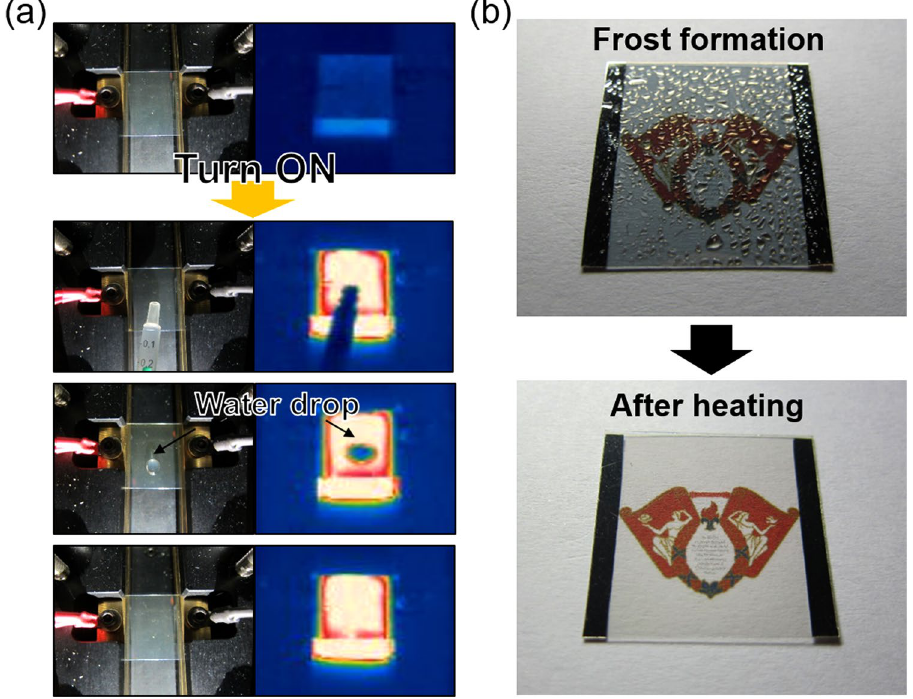
Figure 13. ( a ) Images of the water droplet test on heated TFHs with a SnO 2 /APC/SnO 2 multilayer electrode. ( b ) Defrosting test results of the SnO 2 /APC/SnO 2 multilayer film-based TFHs before and after frost